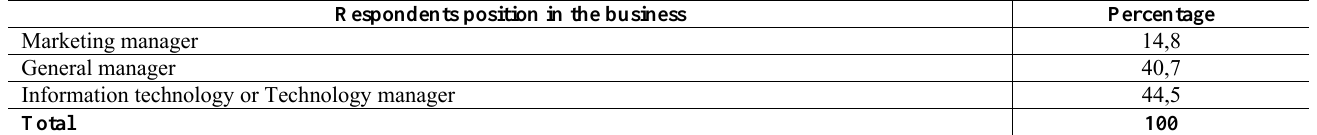
Table 2: Position of the respondent in the business Respondents position in the business